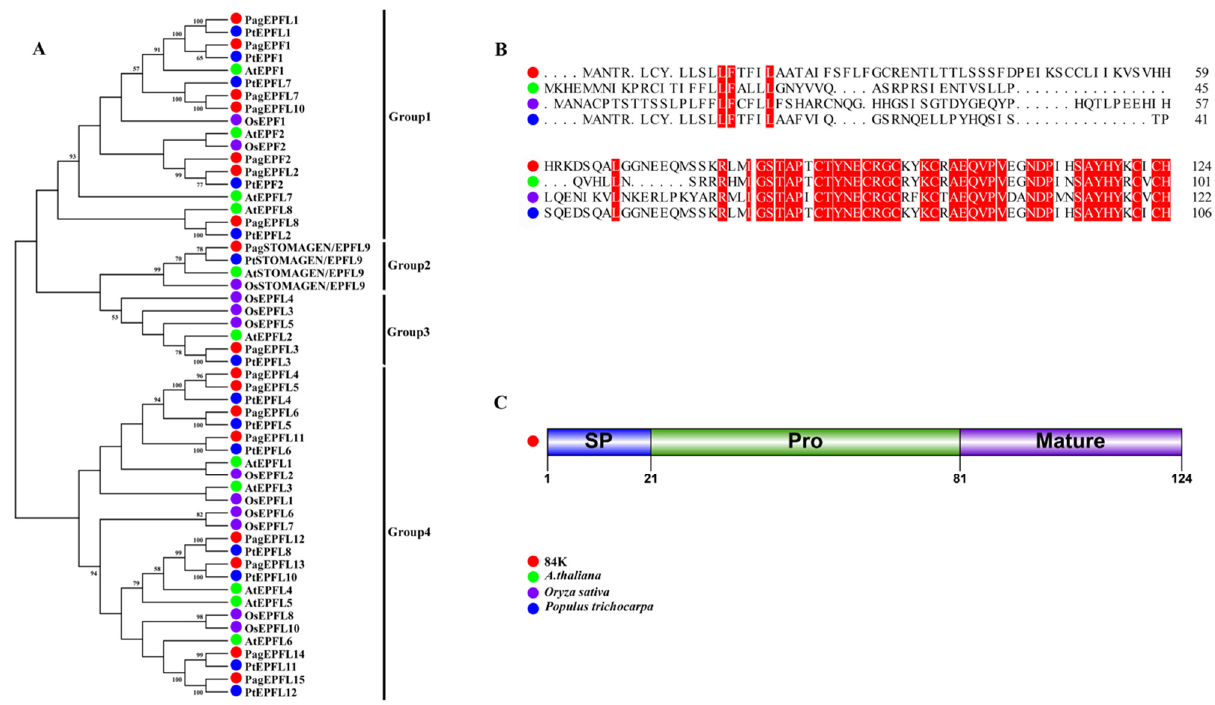
Figure 1. Isolation and identification of PagSTOMAGEN . ( A ) Phylogenetic tree of EPF/EPFL gene family. The bootstrap values are shown. ( B ) Amino acid sequence alignment of STOMAGEN/EPFL9 proteins in 84K, Arabidopsis thaliana , Oryza sativa , and Populus trichocarpa . Identical amino acids are highlighted in red. ( C ) Schematic representation of the domain structure of PagSTOMAGEN/EPFL9 . PagSTOMAGEN/EPFL9 is composed of the signal peptide (SP), the propeptide (Pro), and the mature domain. Amino acid positions are indicated by numbers.